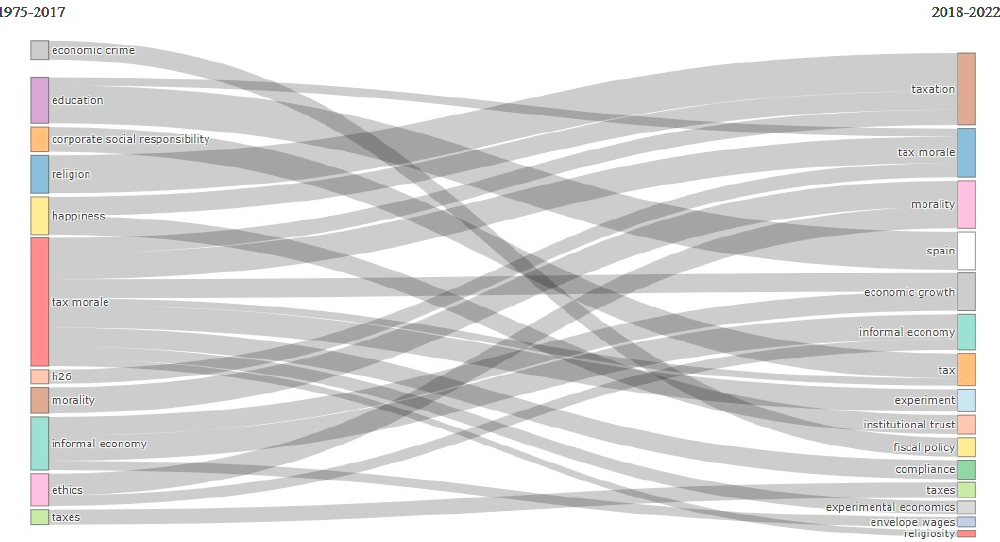
Figure 3. Thematic Figure 3. Thematic evolution.